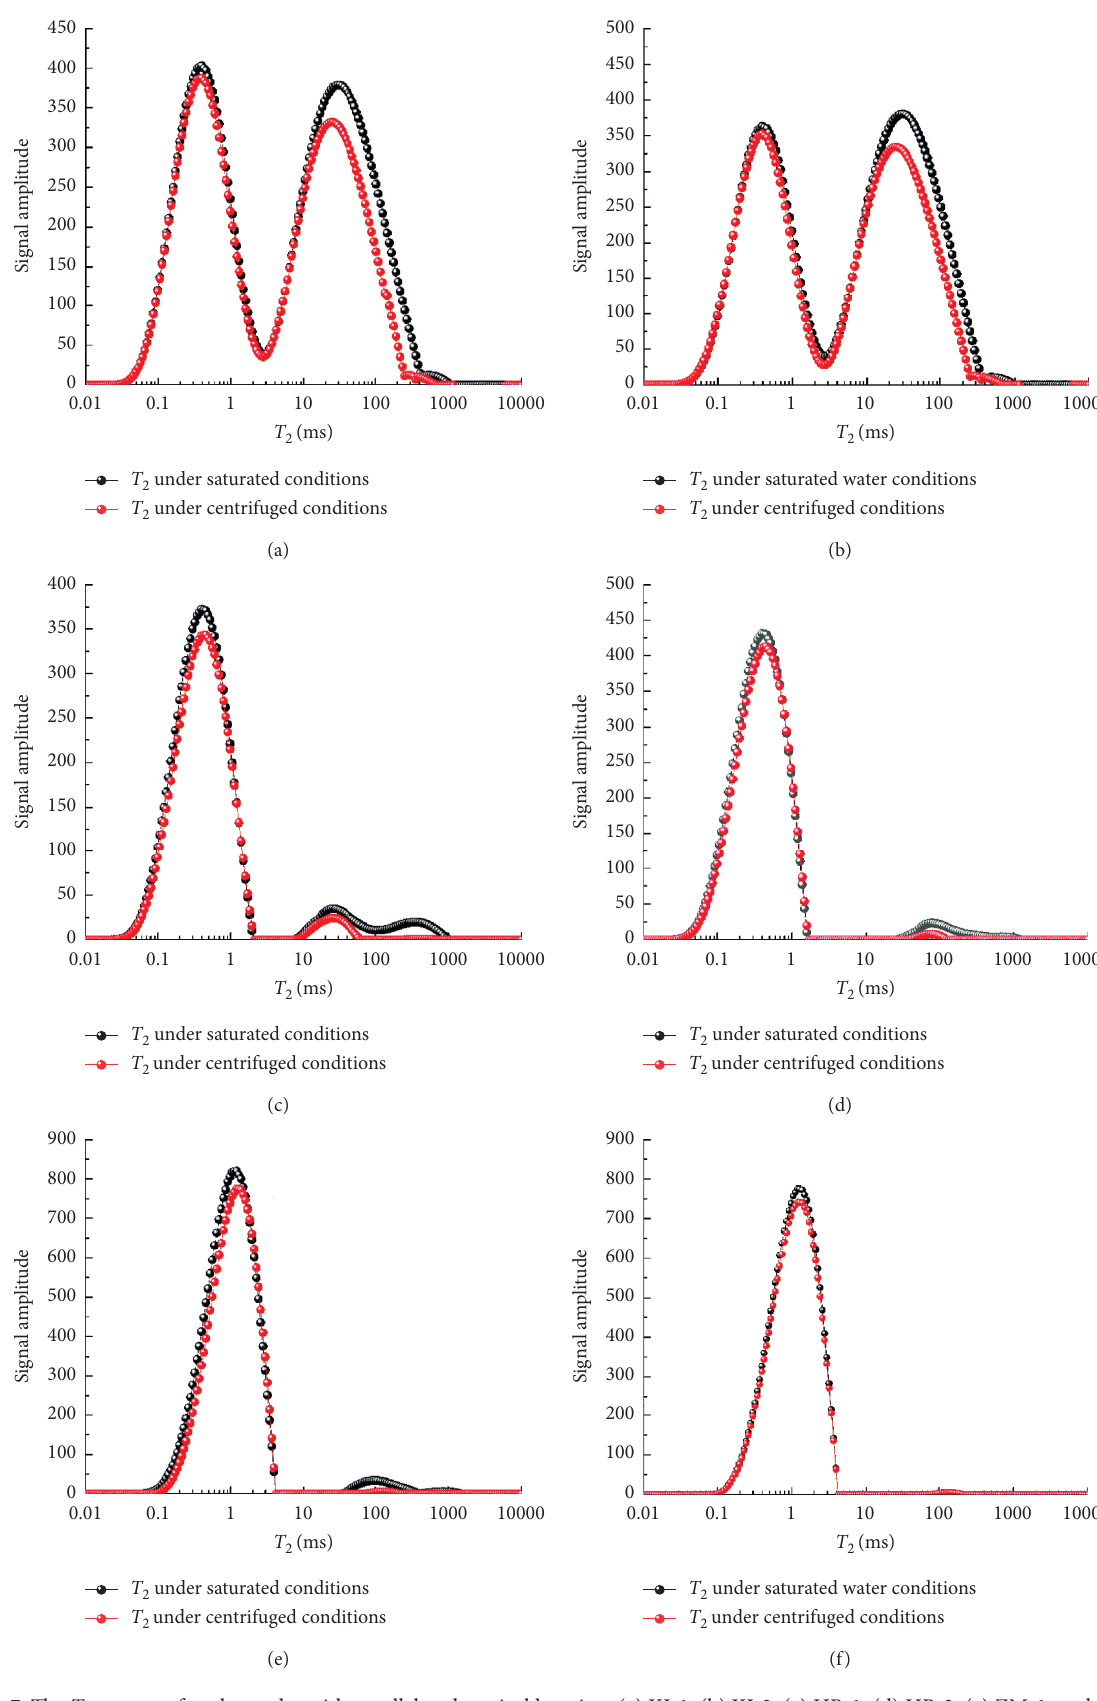
Figure 7: The T 2 spectra of coal samples with parallel and vertical layering. (a) XJ-1, (b) XJ-2, (c) HB-1, (d) HB-2, (e) ZM-1, and (f)